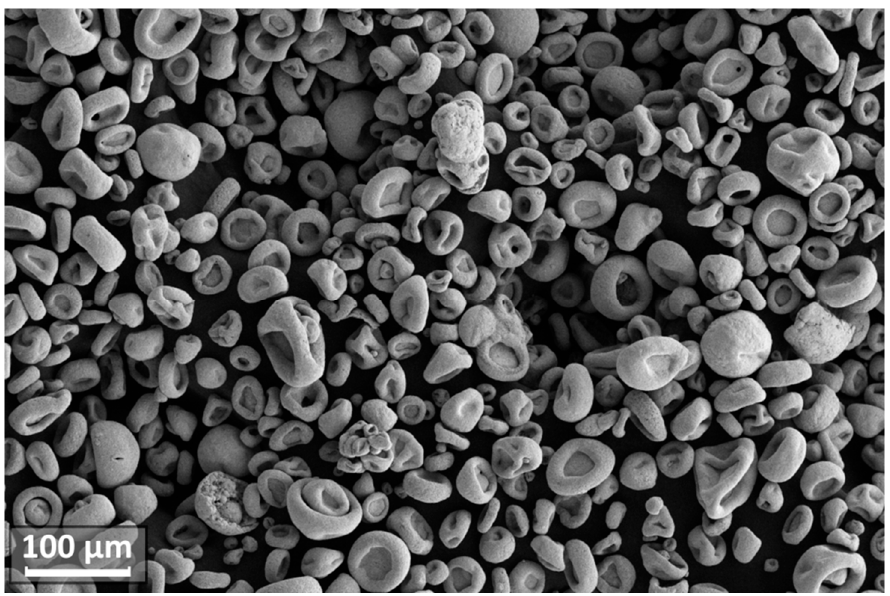
Figure 4. SEM image of W-C-Co microgranules obtained in the process of spray drying. The dispersed composition of separated granule fraction was characterized by the values of distribution parameters D 10 = 23 μ m, D 50 = 37 μ m, and D 90 = 60 μ m (Figure 5). The average particle size of microgranules was 39 μ m.